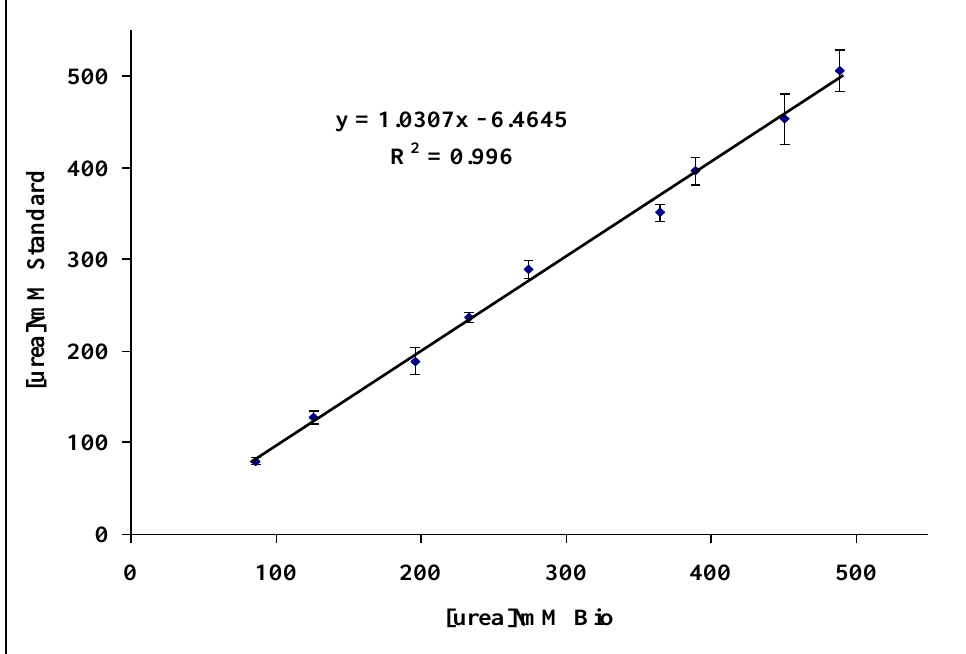
Figure 11. The correlation between biosensor and DMAB standard method for urea determination in urine samples ( n =